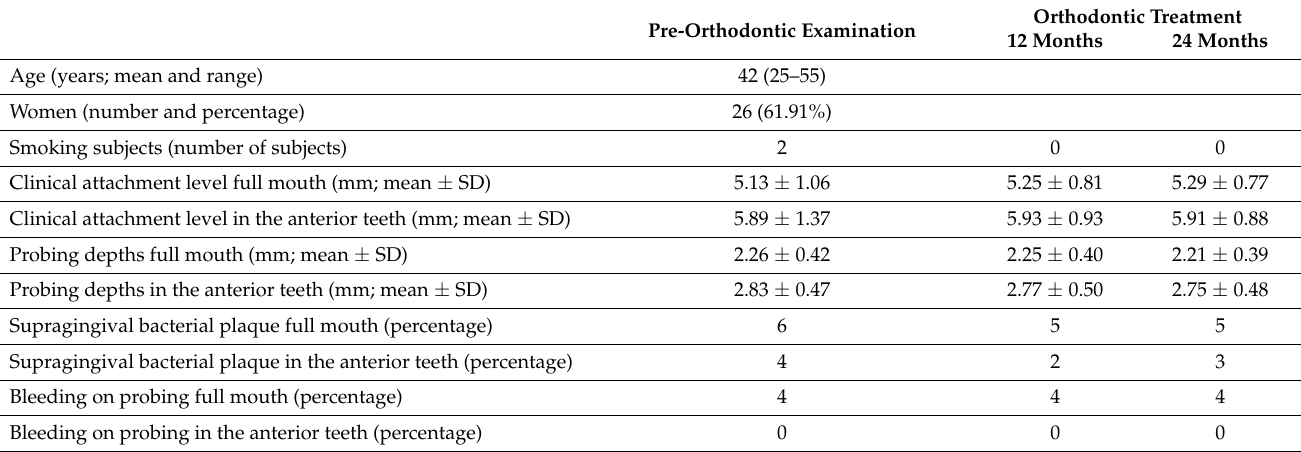
Table 1. Clinical characteristics of the studied